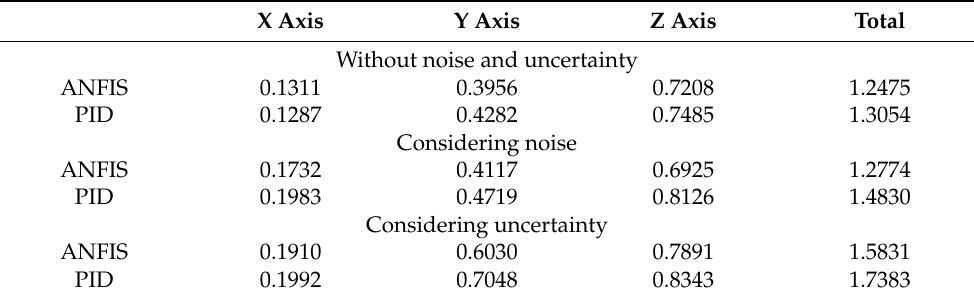
Table 3. Fuel consumption of the PID and ANFIS controllers (in N.M.S). X Axis Y Axis Z Axis Total